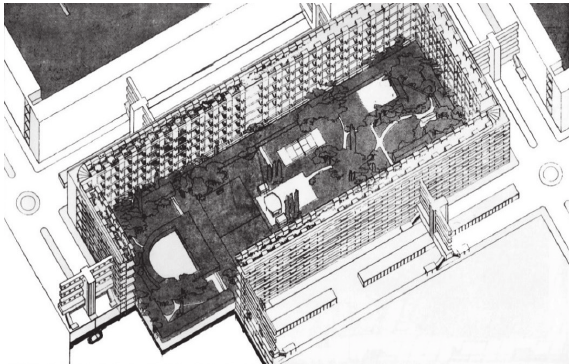
fig. 1. The ‘rue usine’ and the ‘alveolar’ blocks in a view (le Corbusier 1925)